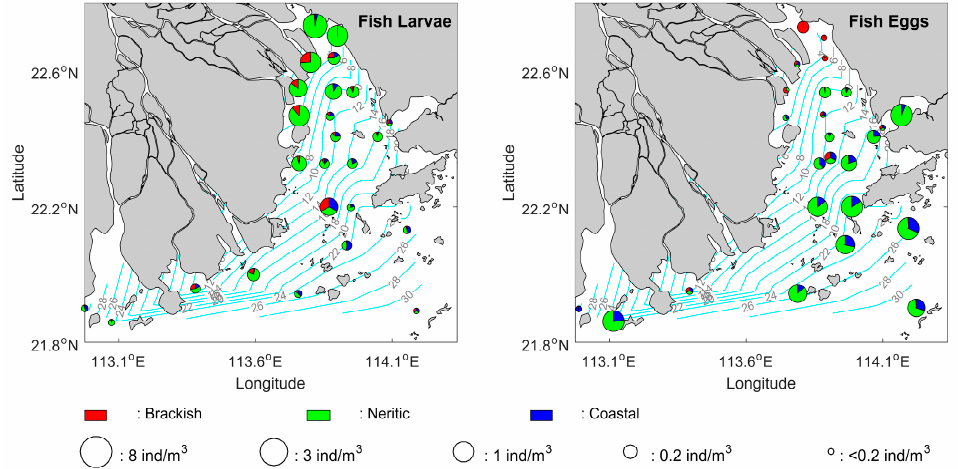
Figure 3. Circle: mean abundance distribution of the fish larvae and eggs in the PRE. Colors: partitions among the brackish, neritic, and coastal species of fish larvae and eggs in the PRE. The light blue represents the contour lines of the corresponding mean surface salinity field.